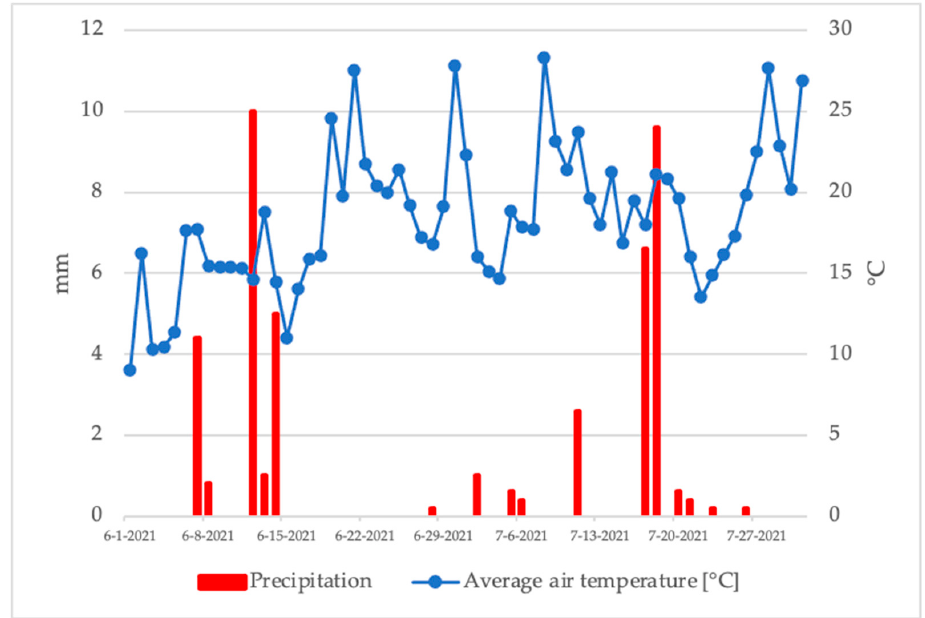
Figure 2. Daily precipitation and average air temperature during the harvesting period.